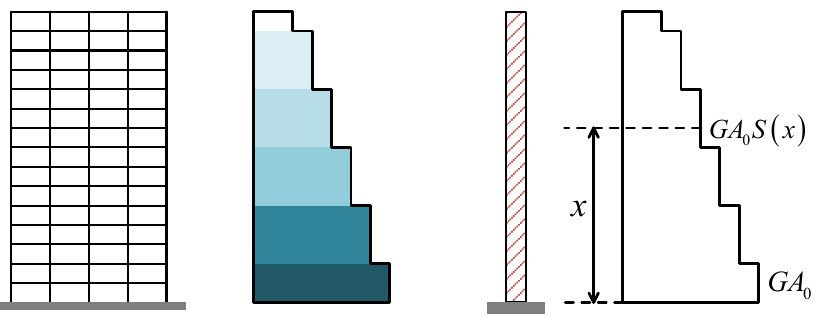
Figure 1. Illustration of the stiffness distribution along building height.